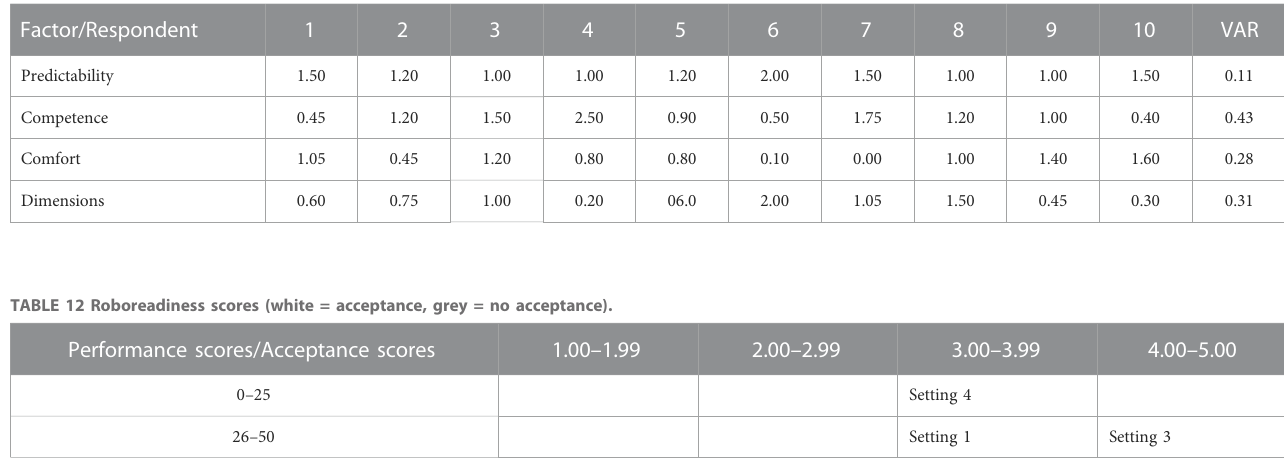
TABLE 11 Scores and variances of the acceptance factors in scenario 3: Road Narrowing.